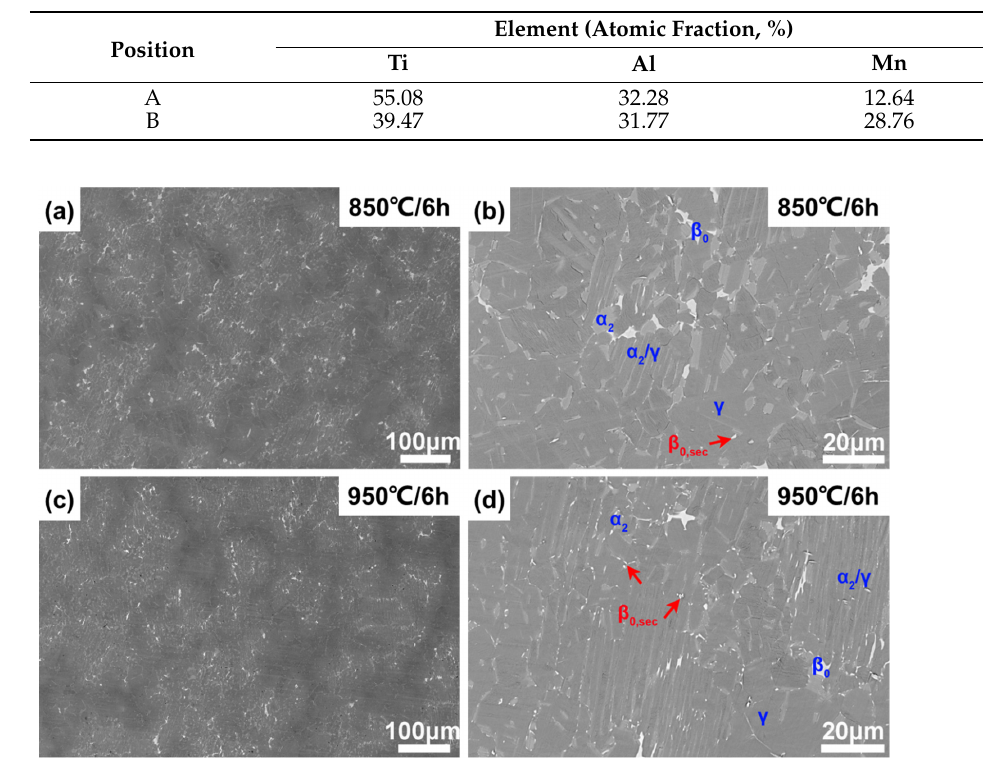
Figure 7. The SEM-BSE photos of TNM alloy after different aging treatments: ( a , b ) HT5, ( c , d ) HT6.